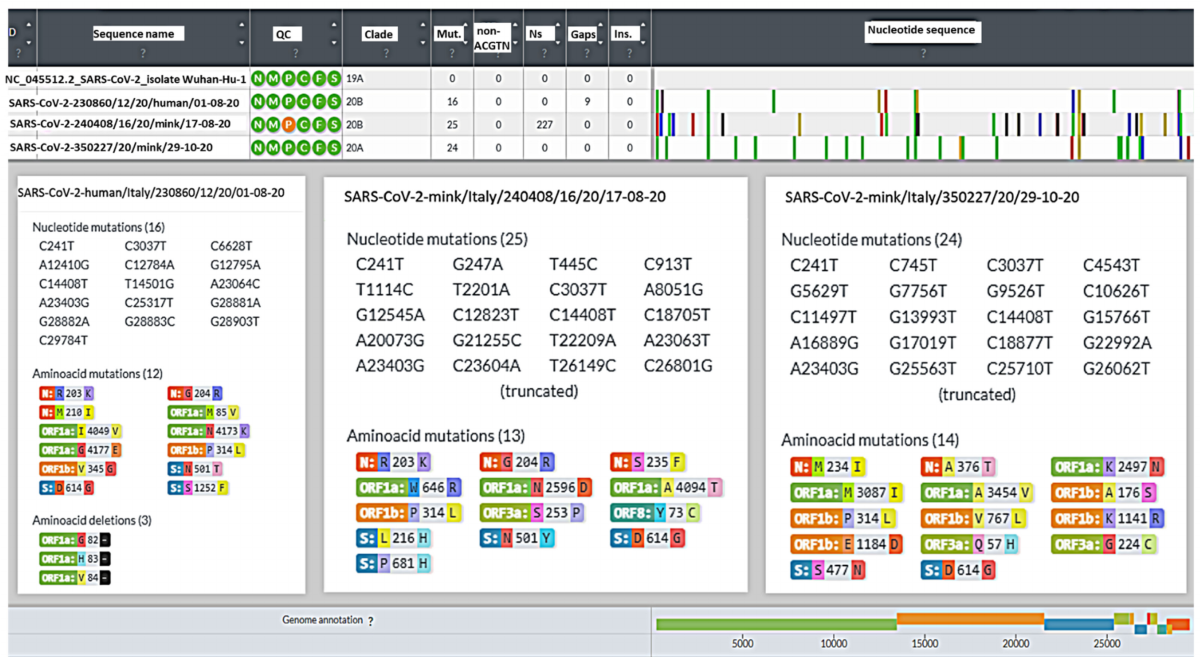
Figure 3. Summary of the results of Nextclade analysis. For each sequence nucleotide, amino acid mutations and deletions are reported.